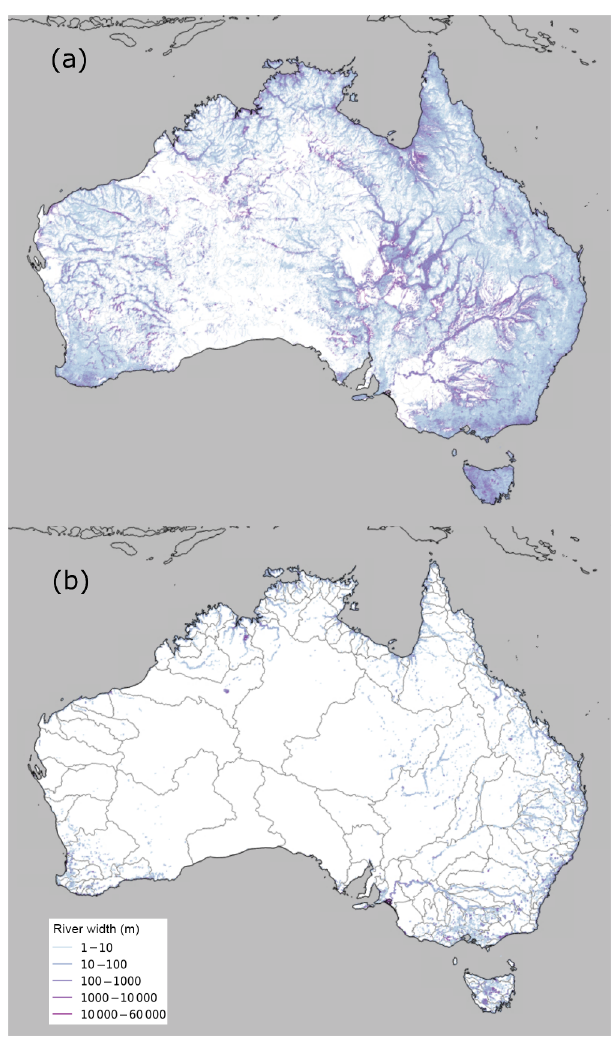
Figure 3. Maximum (a) and minimum (b) river width across Aus- tralia; 218 river regions delineated in grey in (b) .